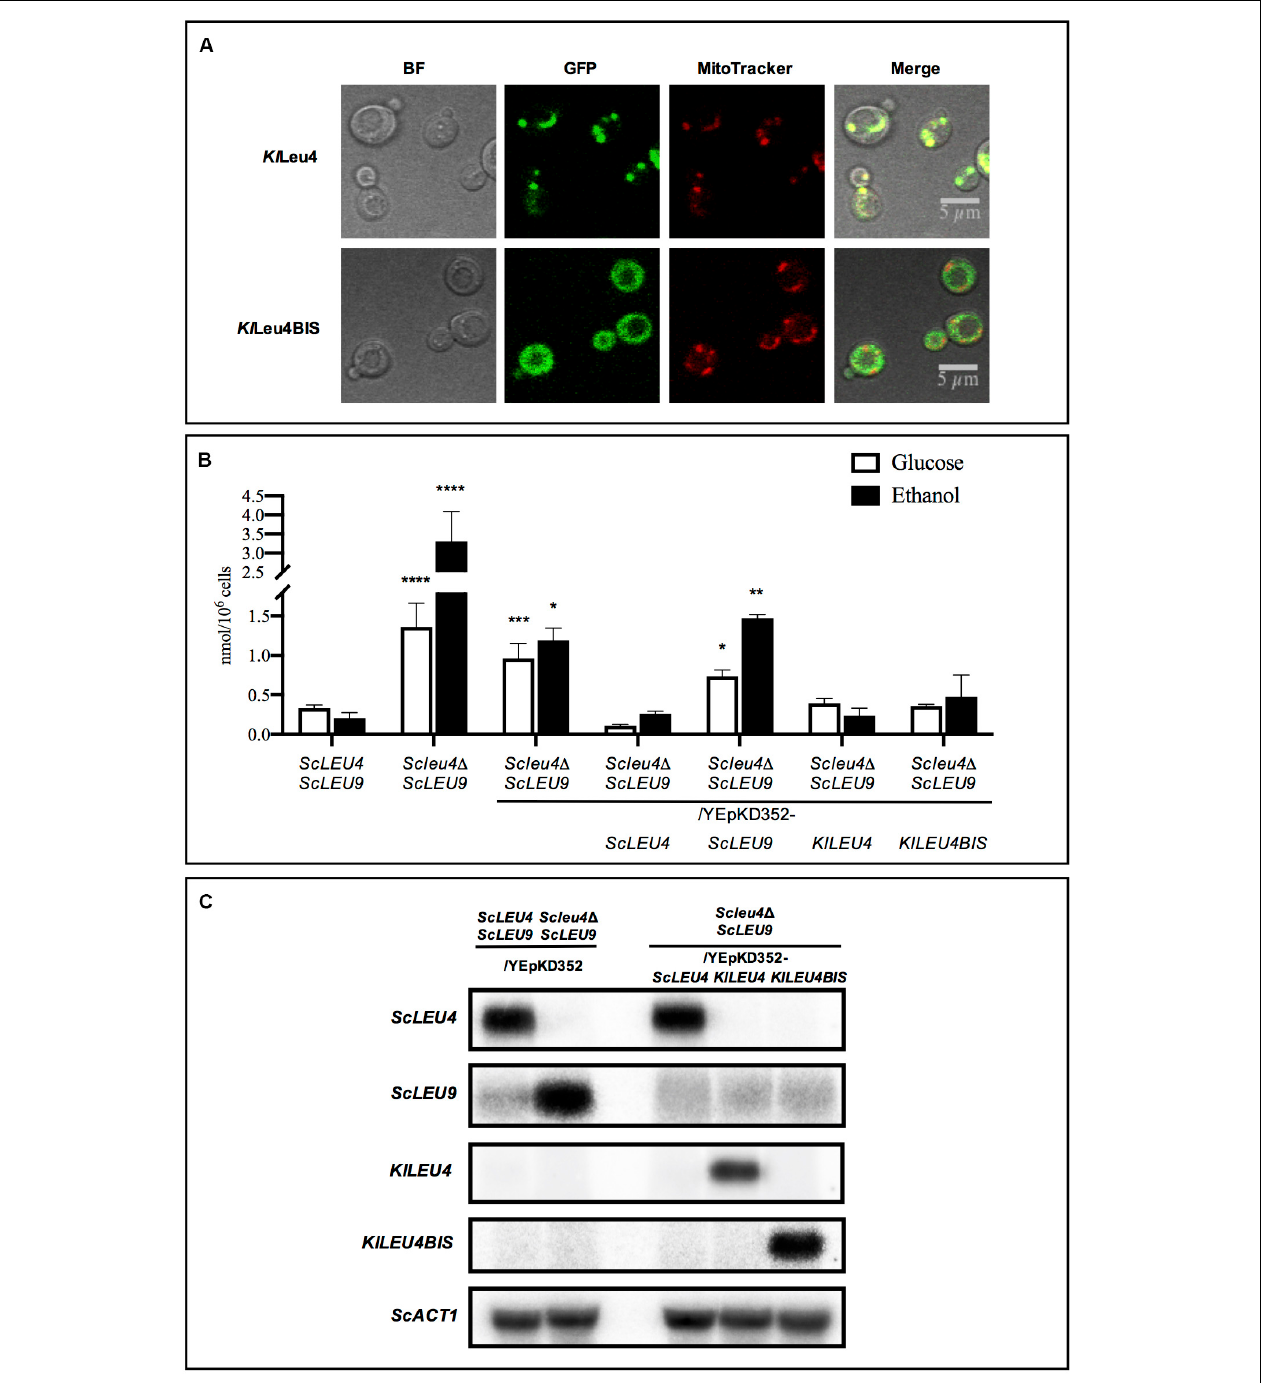
FIGURE 6 | Subcellular localization of Kl Leu4 and Kl Leu4BIS in S. cerevisiae , leucine pools and expression profiles of Scleu4 (cid:49) ScLEU9 transformed with KlLEU4 and KlLEU4BIS . (A) Subcellular localization in S. cerevisiae of Kl Leu4 and Kl Leu4BIS paralogous proteins tagged with yECitrine using confocal microscopy. Strains were grown on minimal medium glucose (2%, w/v), and collected during exponential phase. Representative image of multiple cells from two biological replicates. (B) Leucine pools of wild type ScLEU4 ScLEU9 and derived single ScLEU4 mutant harboring plasmids YEpKD352- ScLEU4 , YEpKD352- ScLEU9, YEpKD352- KlLEU4, or YEpKD352- KlLEU4BIS were prepared as described in section “Materials and Methods. Bars indicate mean ± SD ( n = 3), ∗ p < 0.05, ∗∗ p < 0.01, ∗∗∗ p < 0.001, ∗∗∗∗ p < 0.0001. (C) Northern analysis was carried out as described in section “Materials and Methods.” Total Yeast RNA was prepared from 100 mL aliquots of cultures grown to an OD 600 nm ∼ 0.6 on minimal media with 2% w/v glucose as carbon source. Probes used to monitor expression for each gene are described in section “Materials and Methods.” Blots were scanned using the program ImageQuant 5.2 (Molecular Dynamics).